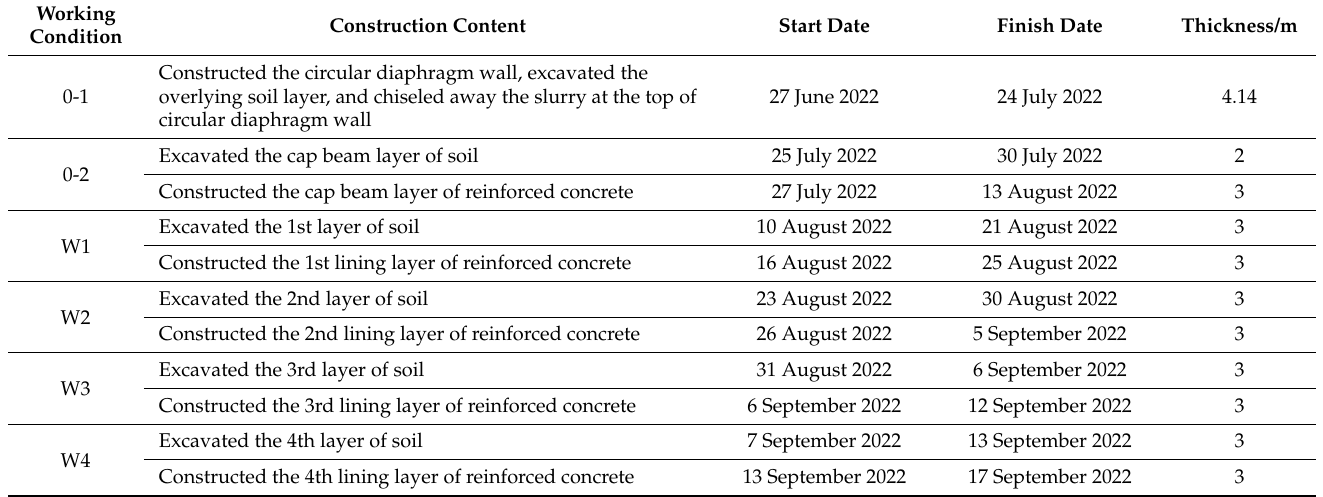
Table 1. Construction situation of the north anchorage foundation